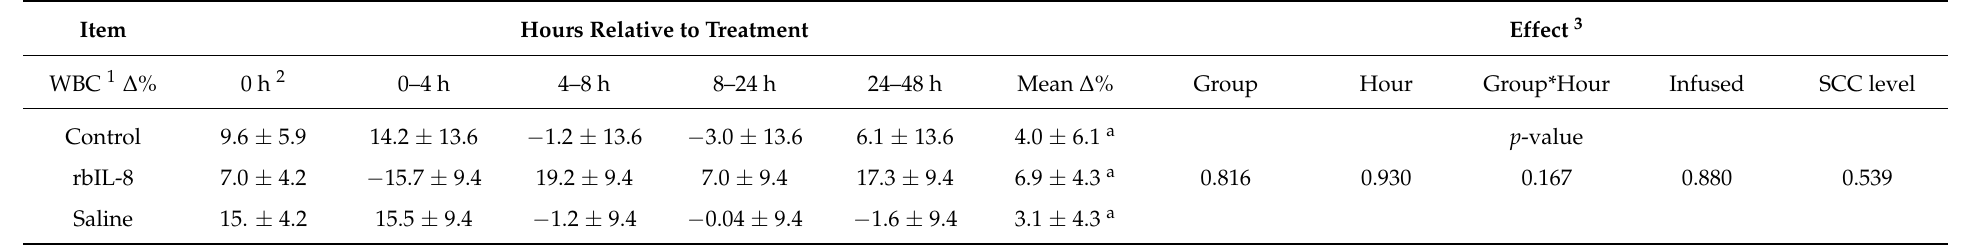
Table 1. The WBC percentage change relative to treatment.